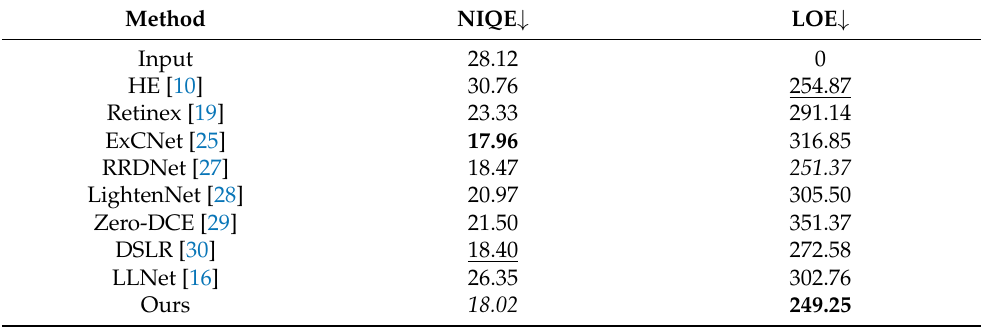
Table 2. The 5 K dataset (unpaired dataset) was quantitatively evaluated according to NIQE and LOE . The best results are shown in bold, the second is italic, and the third is